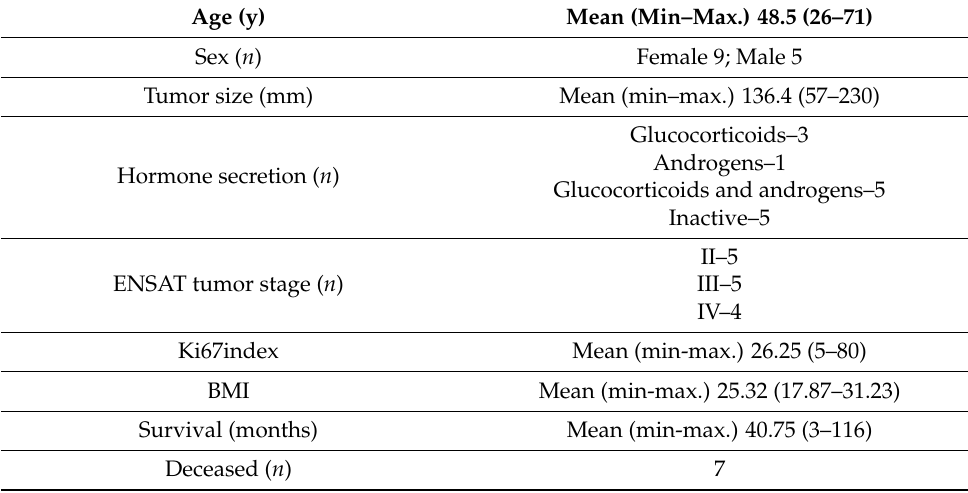
Table 1. Clinical characteristics of patients with